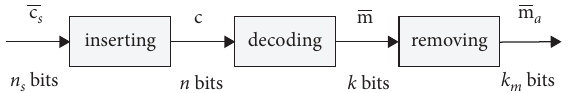
Figure 4: Block diagram of shortening LDPC